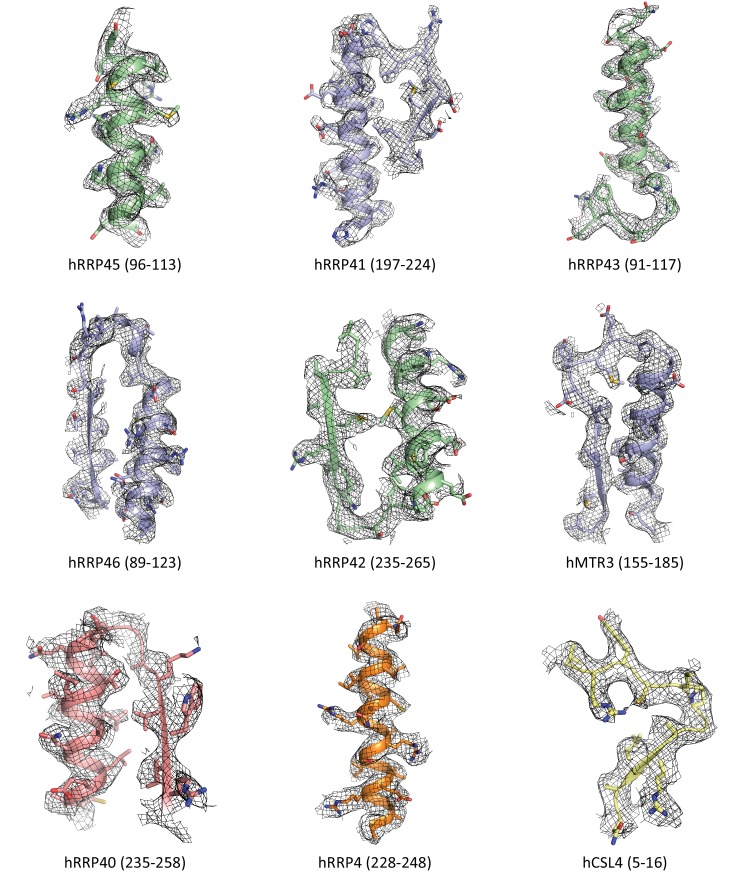
Zoomed in views of the hEXO-9 subunits.Representative parts of the hEXO-9 core exosome complex from the hEXO-10 EM density map, showing secondary structure elements and resolved side chains. Subunit names and highlighted sequences are marked below corresponding views.